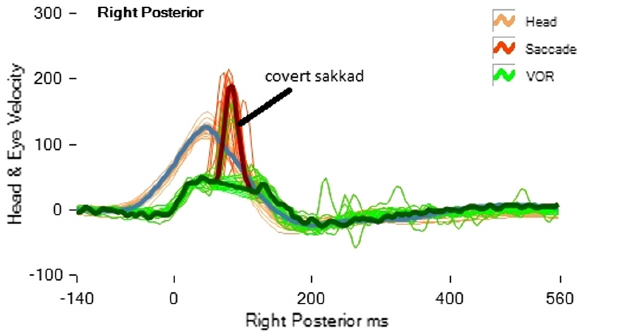
Figure 3. The 2D covert saccade image of the right posterior semicircular canal. Table 5. The Assessment of LL, RL, LA, RP, LP, and RA Parameters in Groups with Respect to the Existence of the Decrease in VOR Gain VOR Gain